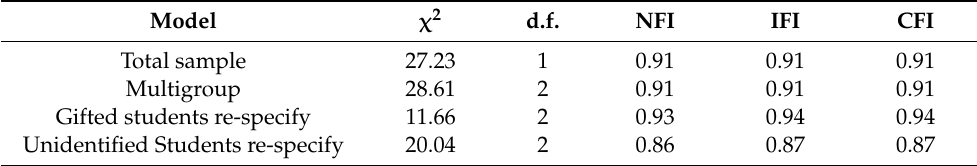
Table 3. Summary of structural equation modeling (SEM) analyses (n = 225).